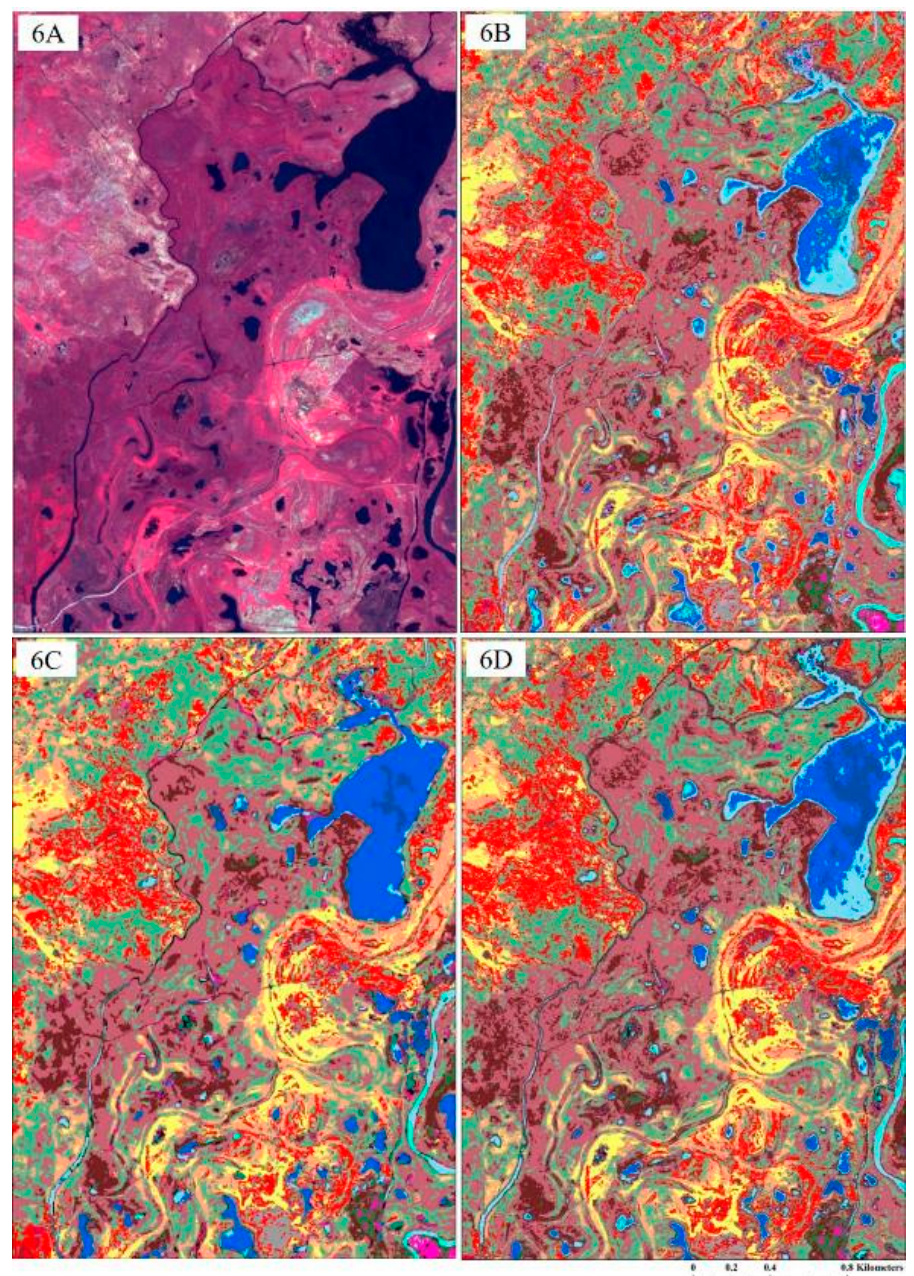
Figure 6. Contrasting the results between the varied methods using a three-layer predictor dataset for inset-5D in Figure 5a: ( A ) Quickbird imagery color composite of bands 2, 3, and 4; ( B ) pixel-based maximum likelihood classification; ( C ) object-based random forest classification; and ( D ) pixel-based random forest classification. Classes correspond to the legend in Figure 5a.